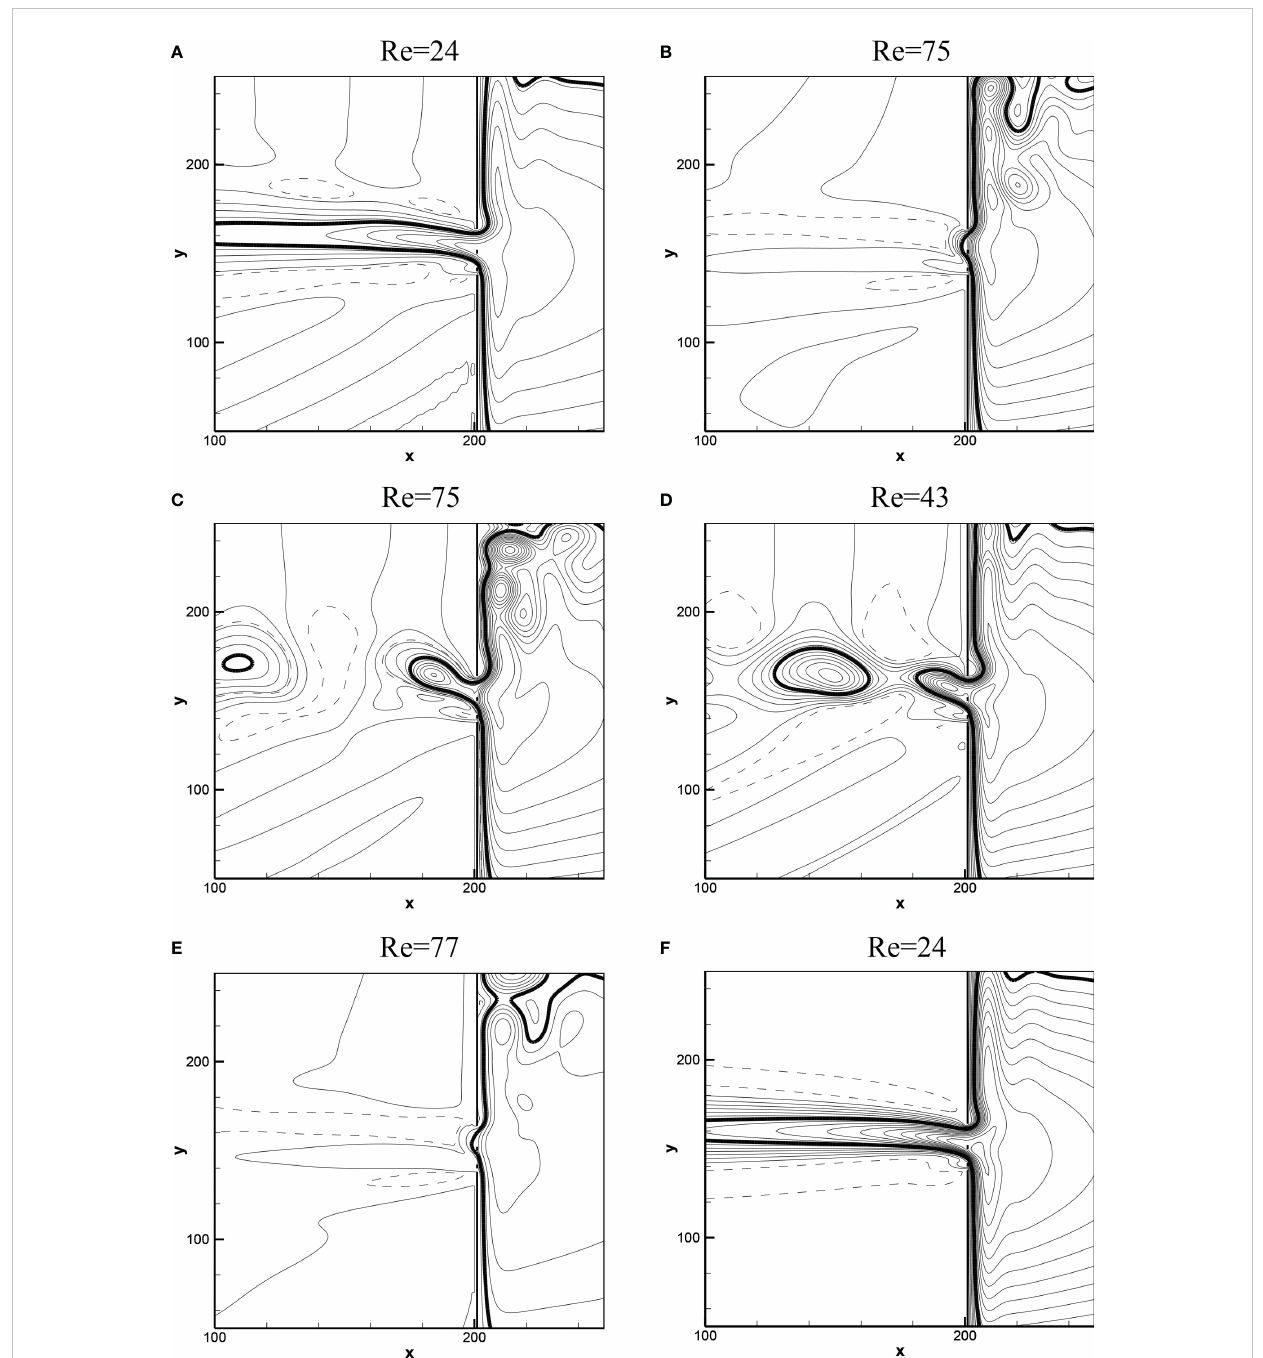
FIGURE 3 Time evolution of the WBC in the vicinity of the gap with two islands under different Re. (A – C) The WBC pattern in the wind stress increasing stage and (D, F) that in the wind stress decreasing stage. (C, E) The Re L -2 and Re P -2 positions in Figure 1. The bold curve represents the y = Q /2 streamline of the WBC and shed eddy. WBC, western boundary